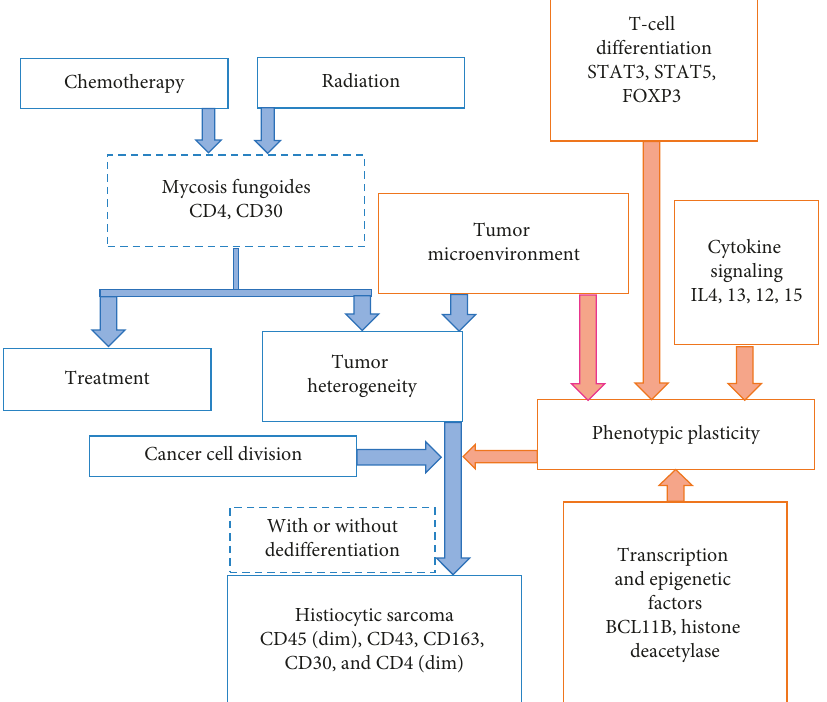
Figure 10: Theoretical malignant evolution and factors contributing to second primary HS in a patient with a protracted history of mycosis